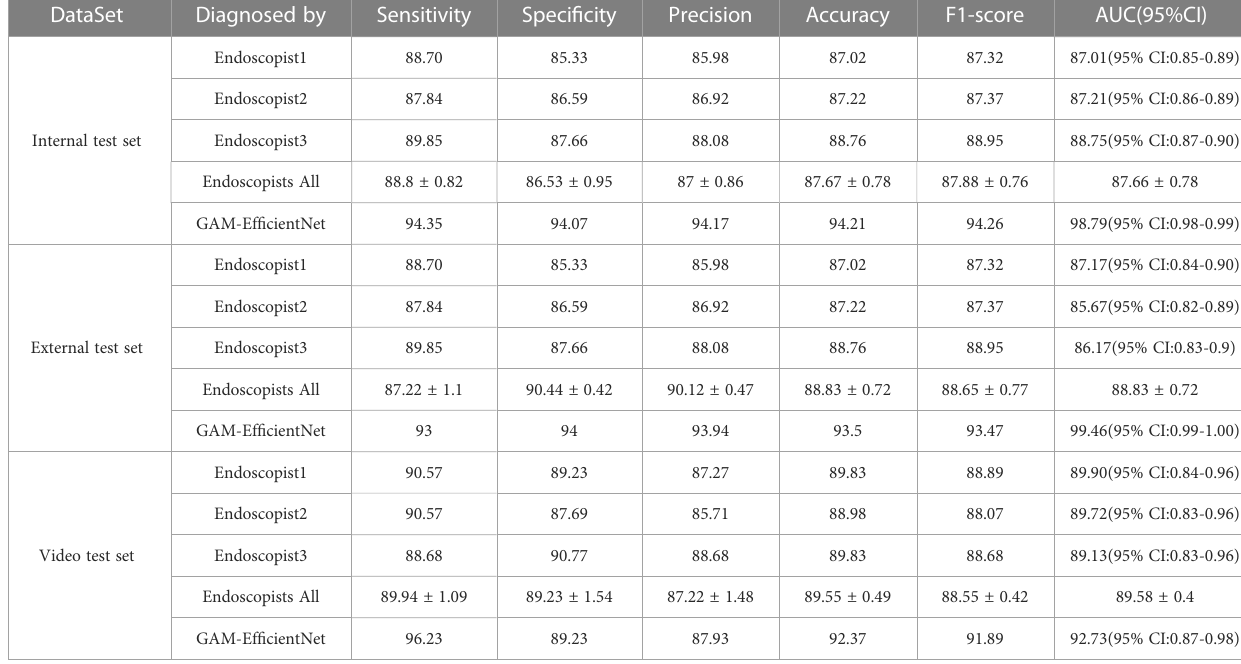
TABLE 3 Diagnostic performance of GAM-Ef fi cientNet and three endoscopists (n%). DataSet